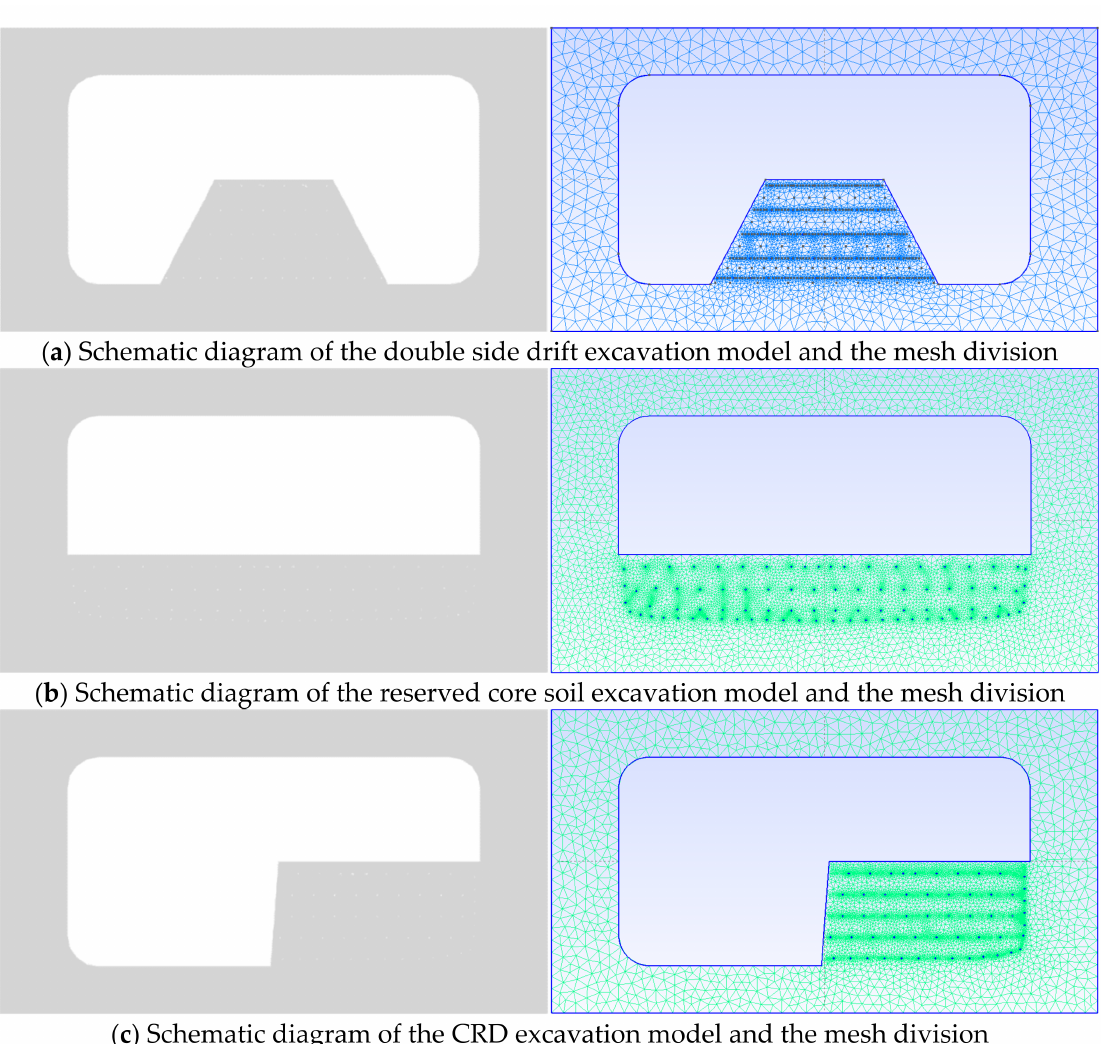
Figure 10. Schematic diagram of the blasting excavation construction model and the mesh